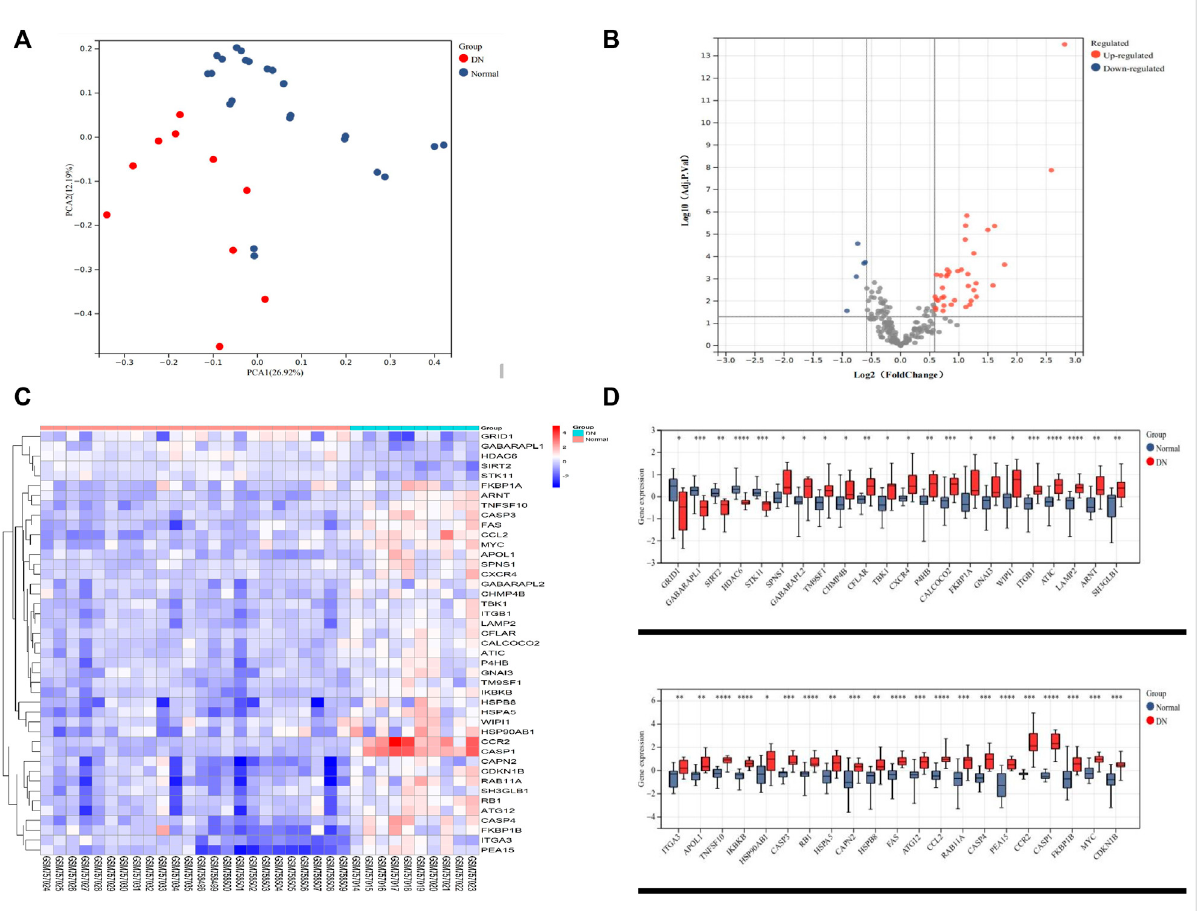
FIGURE 2 Differentially expressed autophagy-related genes in the tubulointerstitium between DN and normal renal tissue. (A) PCA for GSE30122. (B) Volcano plot of 222 DEARGsin DN and normal samples. (C) Heatmap of the 43 DEARGs in DN and normal samples. (D) Boxplot of the 43 DEARGs in DN andnormalsamples. * p < 0.05, ** p < 0.01,*** p < 0.001,and **** p < 0.0001.PCA, principal component analysis; DEARG,differentially expressed autophagy-related gene; DN, diabetic